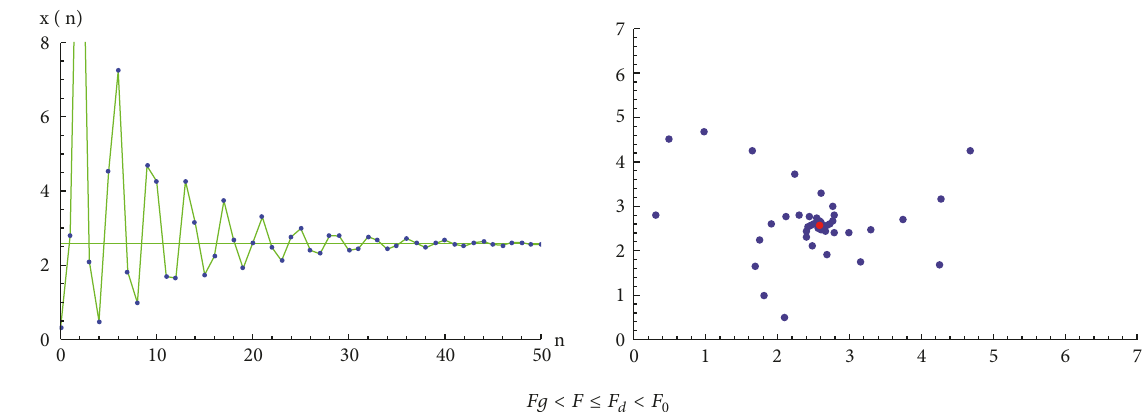
Figure 3: The orbit and the phase portrait for 𝑏 = 2 , 𝑐 = 1 , 𝐵 = 4 , 𝐹 = 28 , 𝐹 𝑔 = 8 , 𝐹 0 = 128 , and (𝑥 0 ,𝑥 −1 ) = (0.3,2.8) generated by Dynamica 4